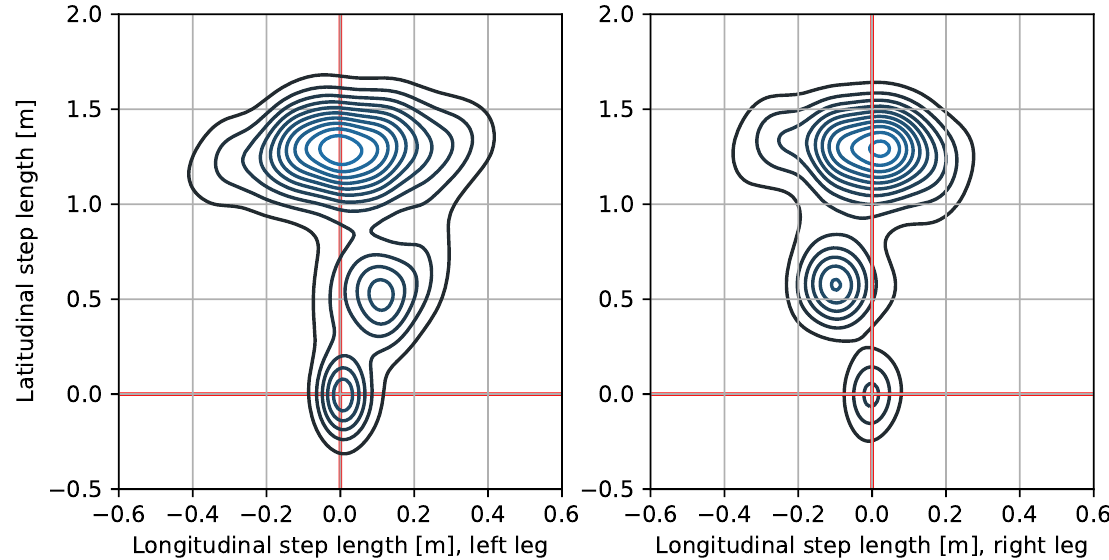
Figure 1. The example of Feet Landing Probability Distribution Function (Gait Style). This particular dataset includes three local maxima that depict three distinctive points of feet landing (based on the number of strides with particular length, and width). The shapes of the probability estimation consist of every subject but vary in the position of statistical moments and dispersions around those, resulting in different distribution in each task phase and across the subjects. We can see that the most frequent step length for the left foot was 1.5 [m] with a step width of 0.8